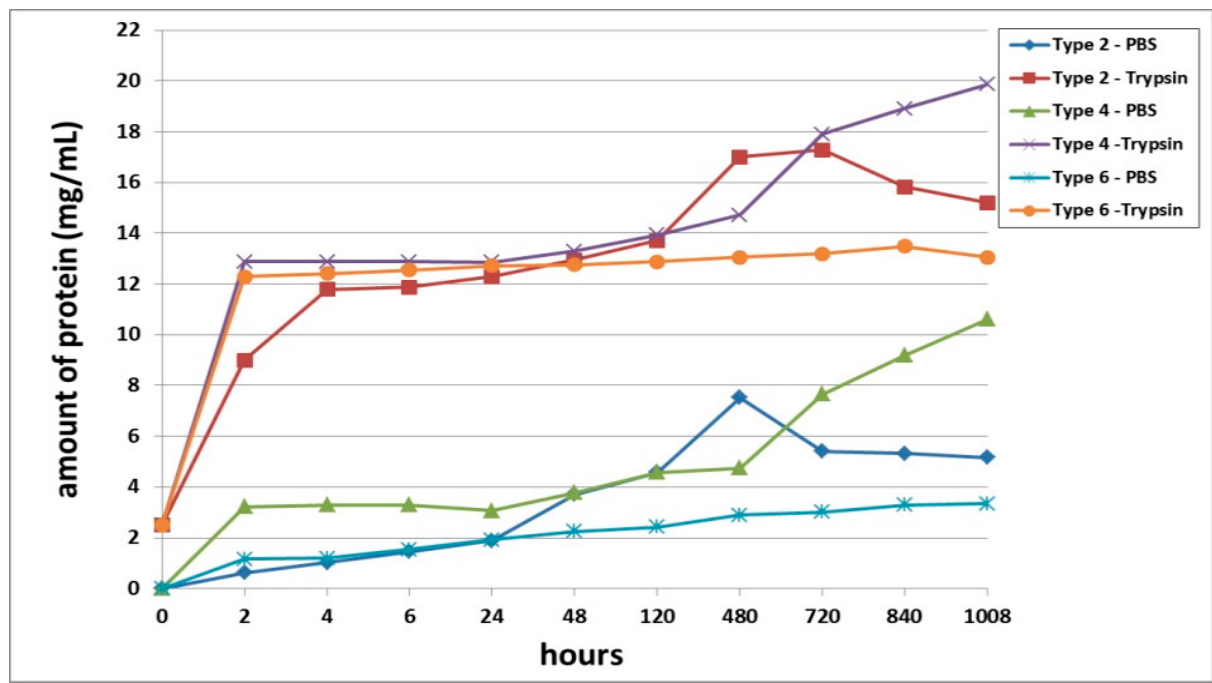
Figure 5. Comparative analysis of passive and enzymatic biodegradation of acellular scaffolds with fish collagen (Type 2), and scaffolds with encapsulated ASCs, pre-cultivated for 24 h (Type 4) or for 6 days (Type 6). Note: PBS—passive biodegradation of scaffolds in PBS solution; Trypsin—enzymatic biodegradation of scaffolds in a solution of the hydrolytic enzyme trypsin.